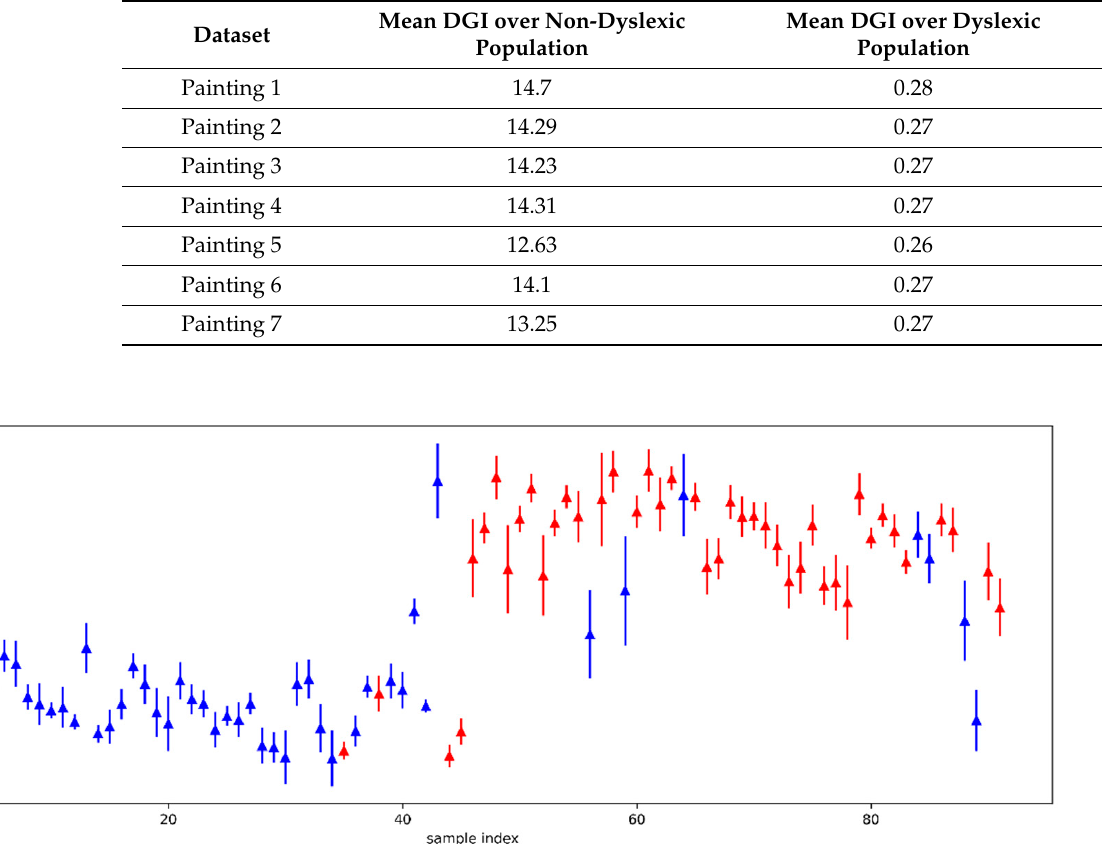
Table 3. DGI mean values for the dyslexic and non-dyslexic populations for each of the seven paintings datasets.